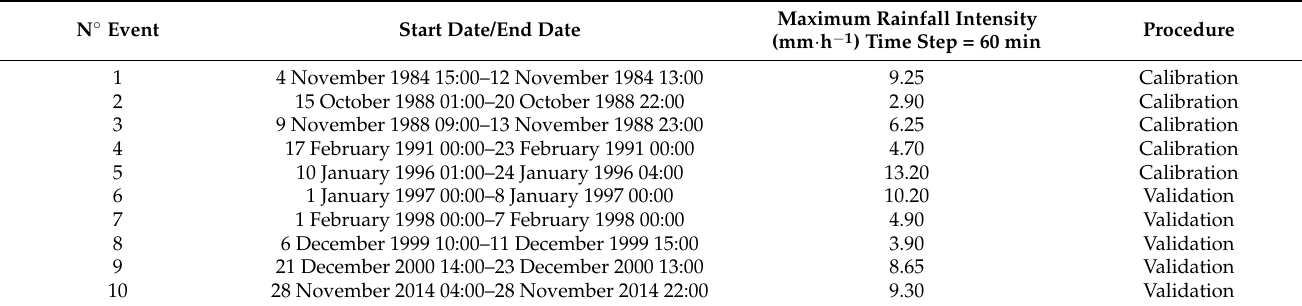
Table 4. Classification of events according to applied modeling